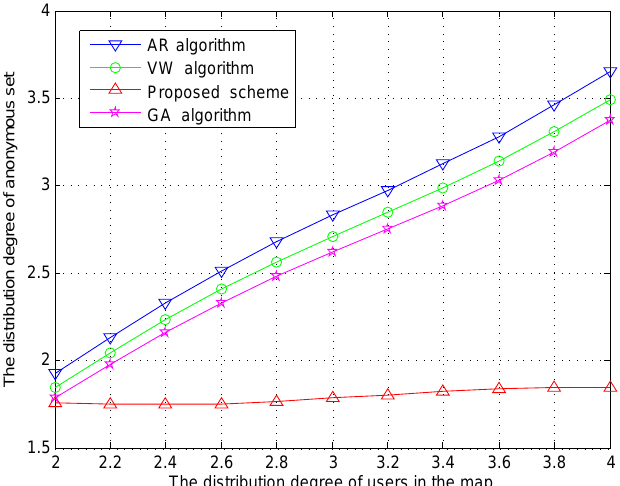
Figure 8. The distribution degree of anonymous set comparison with different user distribution degree. ( k 0 = 10, l 0 = 3, λ 0 =